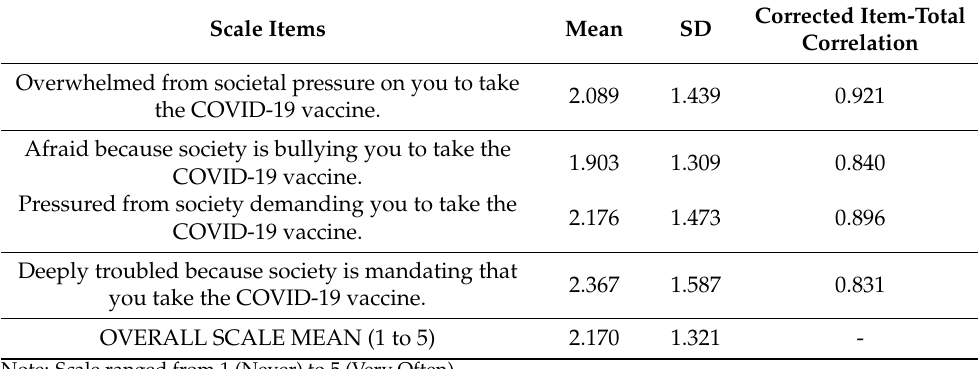
Table 2. Cont. Scale Items Mean SD